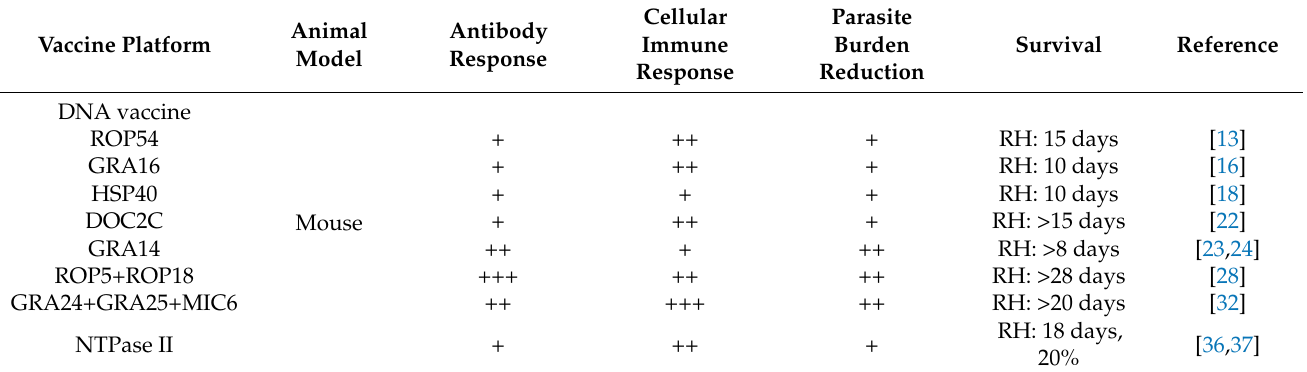
Table 1. An overview of the T. gondii DNA vaccines and their efficacies. Only the studies that assessed all four of the parameters listed below were selected and referenced in the table. Survival refers to the total duration of survival for immunized mice. +, weak; ++ intermediate; +++ strong. Parasite Cellular Animal Antibody Burden Survival Reference Immune Vaccine Platform Model Response Reduction Response DNA